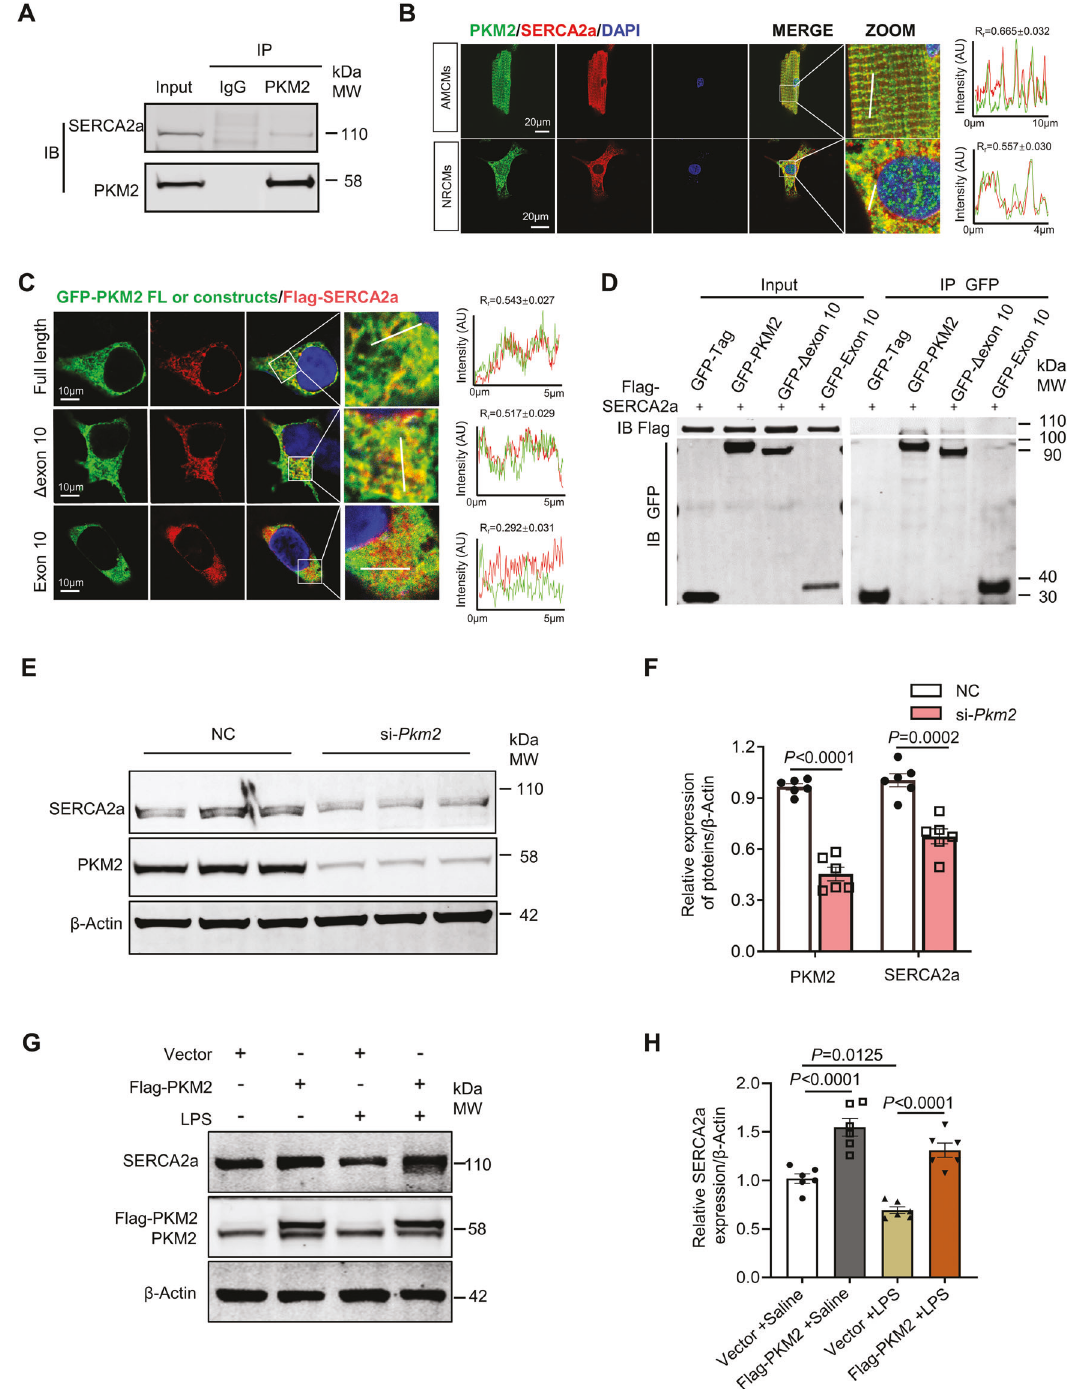
Fig. 4 PKM2 interacted with SERCA2a and regulated its expression. A Immunoprecipitation assay to validate SERCA2a using anti-PKM2 antibody in NRCMs. B Representative immuno fl uorescence images showing the co-localization of PKM2 (green) and SERCA2a (red) in AMCMs and NRCMs by confocal immuno fl uorescence analysis (scale bars, 20 μ m). Line pro fi le analyses showing the distribution and intensity of fl uorescence signals. The Pearson ’ s coef fi cient was measured from the images using ImageJ software ( n = 18). C Immuno fl uorescence analysis of the colocalization of exogenous-expressing SERCA2a (red) and PKM2 full-length and truncated forms. The right column indicates the line plot pro fi les of the region of interest ( n = 15). D Co-immunoprecipitation by anti-GFP antibody (PKM2 full-length and truncated forms) with Flag tagged SERCA2a in transiently transfected HEK-293T cells. E , F Western blot and quantitation of SERCA2a and PKM2 expression in NRCMs after Pkm2 knockdown. β -Actin served as loading control, n = 6. G , H Western blot and quantitation of SERCA2a expression in NRCMs co- administered with PKM2 overexpressing plasmid and LPS. β -Actin served as loading control, n = 6. Values represent the mean ± SEM of at least three independent experiments.